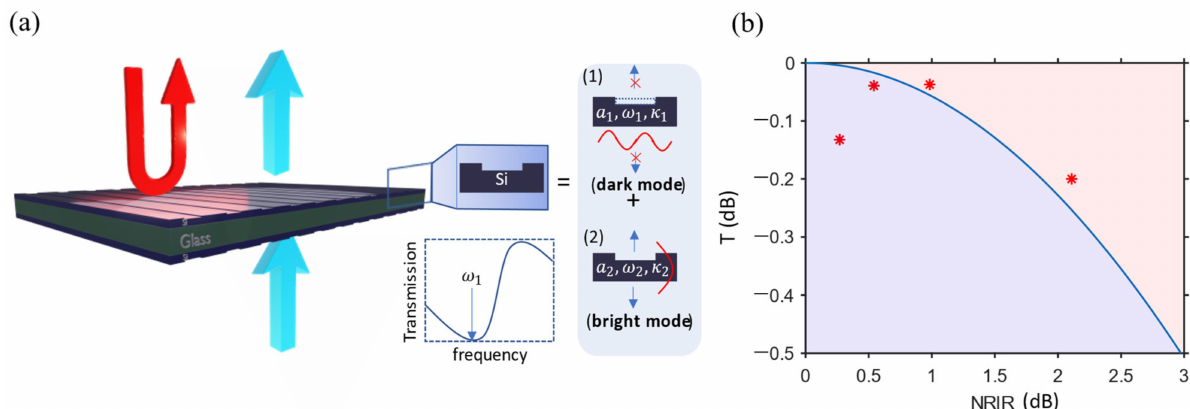
Figure 1. ( a ) Schematic depicts the nonlinearity-based nonreciprocal metasurface bilayer presented in this work. The arrows represent high power plane waves pointing to the direction of propagation that are blocked and reflected when propagating from the top to the bottom (red arrow) and transmitted when propagating from the bottom to the top (blue arrows). The zoomed in box shows one unit cell of the metasurface top layer made of Si (the bottom layer is similar, but with different geometrical parameters). Upon the plane wave excitation, the transmission from each layer takes the Fano line shape in the dashed box, and can be explained by the interference between: (1) the dark narrow band mode similar to the waveguide mode inside the unperturbed slab (i.e., with filled Si in the dashed box) and (2) the bright wideband mode that resembles a Fabry–P é rot mode or background reflection, as shown in the top and bottom of the shadowed rectangle, respectively. ( ω ) are the resonance frequencies of the modes, while their complex amplitudes are ( a ) and their coupling rates 1 , ω 2 1 , a 2 to the free space are ( κ 1 , κ 2 ) for the dark and bright mode, respectively. ( b ) Transmission in the forward direction vs the nonreciprocal intensity range for the various nonlinear resonator designs presented in this work (red asterisks). The blue shaded region corresponds to the bound in Equation